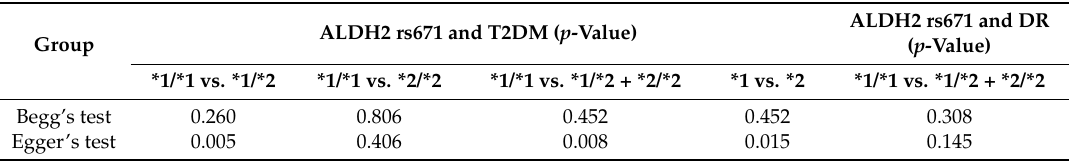
Table 5. Begg’s and Egger’s test for funnel plot asymmetries.